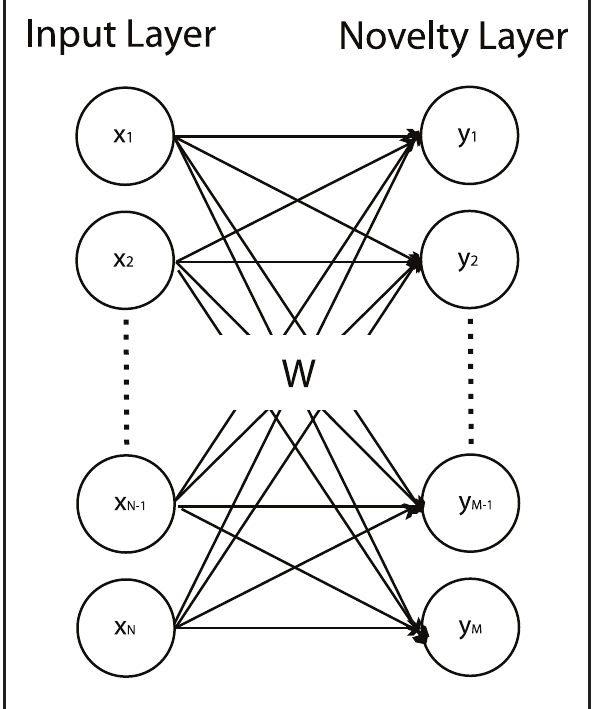
Figure 14. The Infomax model. Circles represent units and arrows denote connections between the input units on the left and the novelty units on the right. There is no output from the network as such since the response of the network is a function of novelty unit activations. Following [59] we therefore do not draw an output layer.